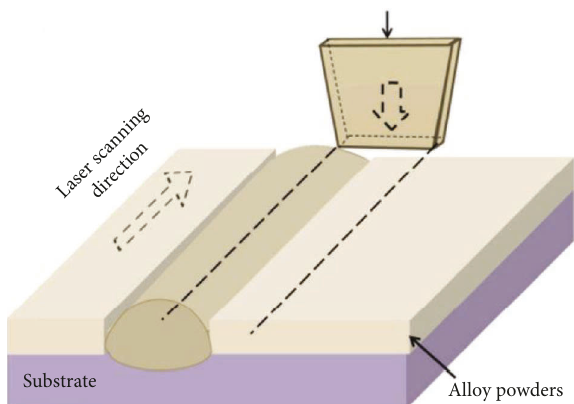
Figure 5: Laser cladding [23].